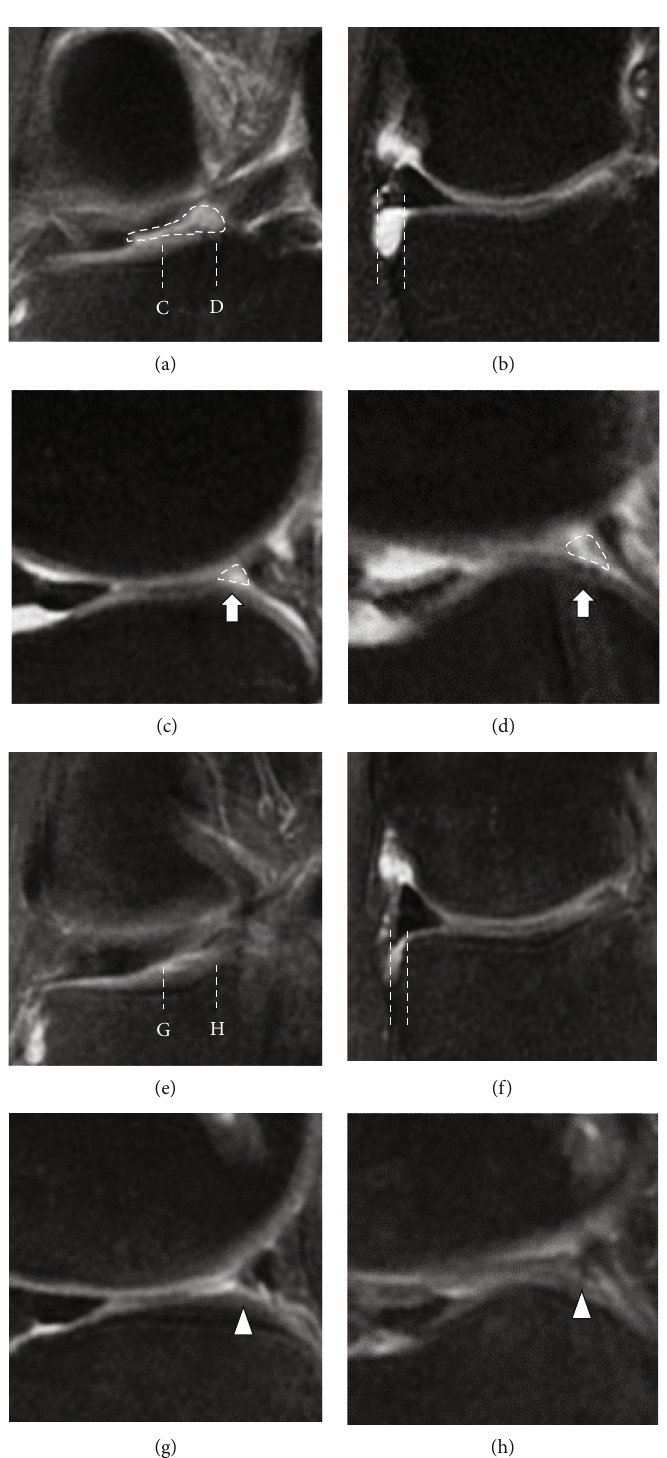
Figure 3: Comparison of the (a – d) preoperative and (e – h) postoperative MRI fi ndings. (a) Preoperative MRI showed a linear defect in the coronal plane (dotted area). (b) The length of the lateral meniscus extrusion (LME) was 3.1mm (length between dashed lines). (c, d) The reference lines of the sagittal plane are shown as dotted lines in (a) (C and D, respectively). Ghost sign in two consecutive sagittal planes with a 10mm interval (dashed area). (e) One year after the operation, the preoperative gap was fi lled with tissue continuous to the tibial attachment of the LMPR in the coronal plane. (f) The length of LME was 1.6 mm (1 year postoperatively). (g, h) The reference lines of the sagittal plane are shown as dotted lines in (e) (G and H, respectively). The disappearing ghost sign in two consecutive sagittal planes with a 10 mm interval